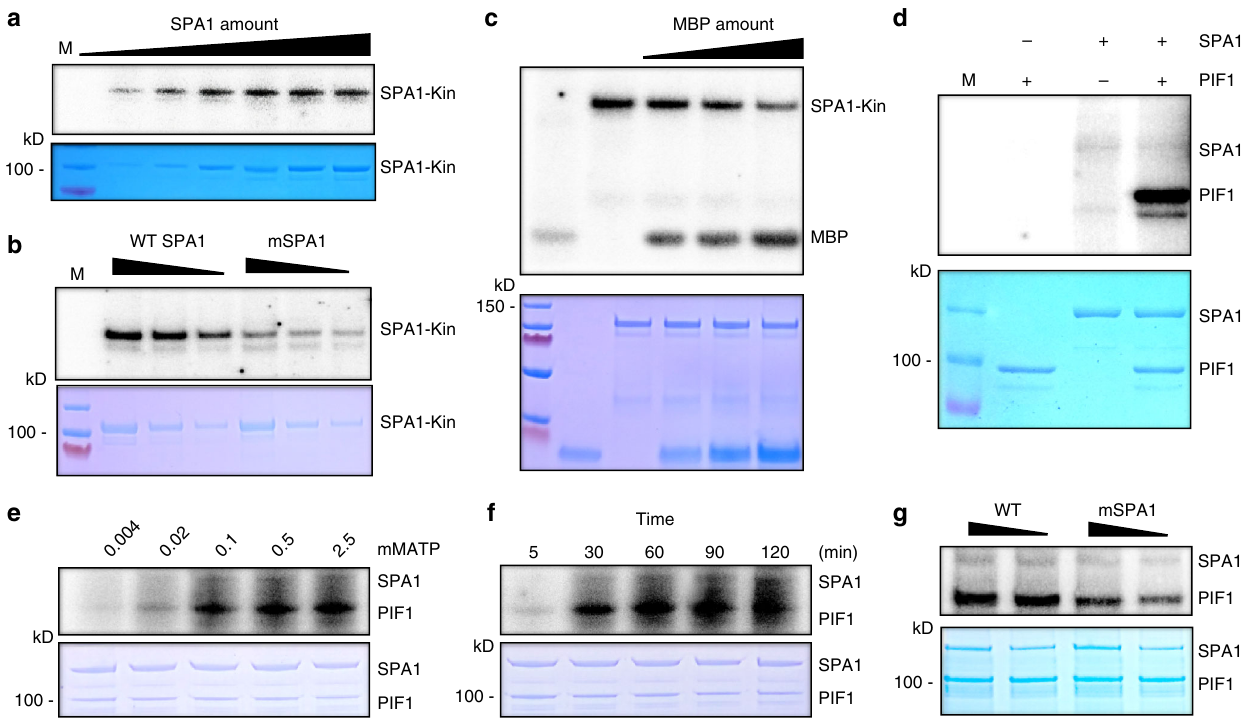
Fig. 1 SPA1 acts as a ser/thr protein kinase. a SPA1 kinase domain (SPA1-Kin) puri fi ed from E. coli showed an auto-phosphorylation activity in a concentration-dependent manner (autoradiogram on top panel). Bottom panel shows the protein level in a Coomassie-stained gel. M, indicates protein marker. b A conserved amino acid mutation on the SPA1 kinase domain reduces the auto-phosphorylation activity of SPA1 (autoradiogram on top panel). Bottom panel shows the protein level in a Coomassie-stained gel. c The N-terminal kinase domain of SPA1 exhibits kinase activity in the presence of myelin basic protein (MBP); a general kinase substrate (autoradiogram on top panel). Bottom panel shows the protein levels in a Coomassie-stained gel. d Full- length SPA1 puri fi ed from Pichia pastoris phosphorylates PIF1 in vitro (autoradiogram on top panel). Bottom panel shows the protein levels in a Coomassie- stained gel. e ATP-dependent kinase assays of full-length SPA1 on PIF1 (autoradiogram on top panel). ATP concentrations used were 0.004, 0.02, 0.1, 0.5, and 2.5 mM. Bottom panel shows the protein levels in a Coomassie-stained gel. f Kinetic analysis of the kinase activity of the full-length SPA1 on PIF1 (autoradiogram on top panel). Bottom panel shows the protein levels in a Coomassie-stained gel. g A conserved amino acid mutation on the full-length SPA1 kinase domain reduces the SPA1 kinase activity toward PIF1 (autoradiogram on top panel). Bottom panel shows the protein levels in a Coomassie- stained